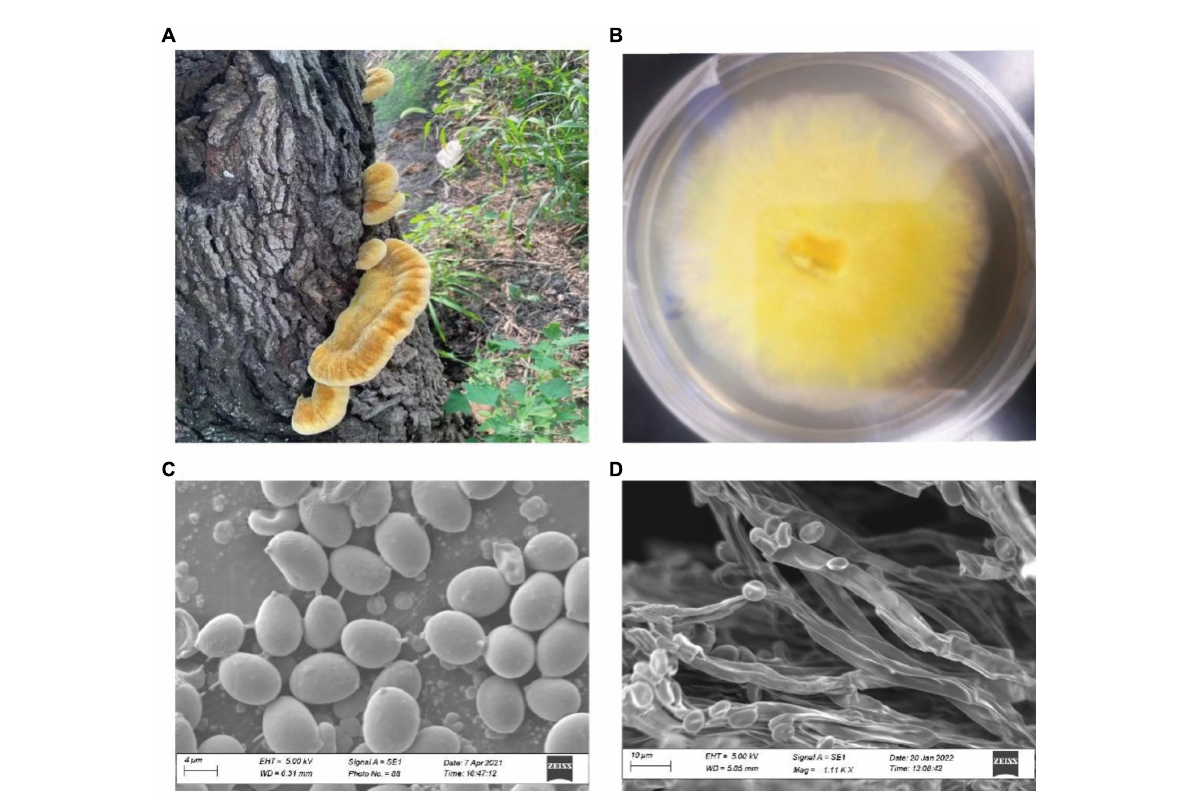
FIGURE1 The fruiting bodies of I. hispidus and the monokaryotic strain used for genome sequencing. (A) The fruiting bodies of I. hispidus . (B) Mycelia of I. hispidus. (C) Scanning electron microscope image of I. hispidus spores. (D) Scanning electron microscope image of I. hispidus